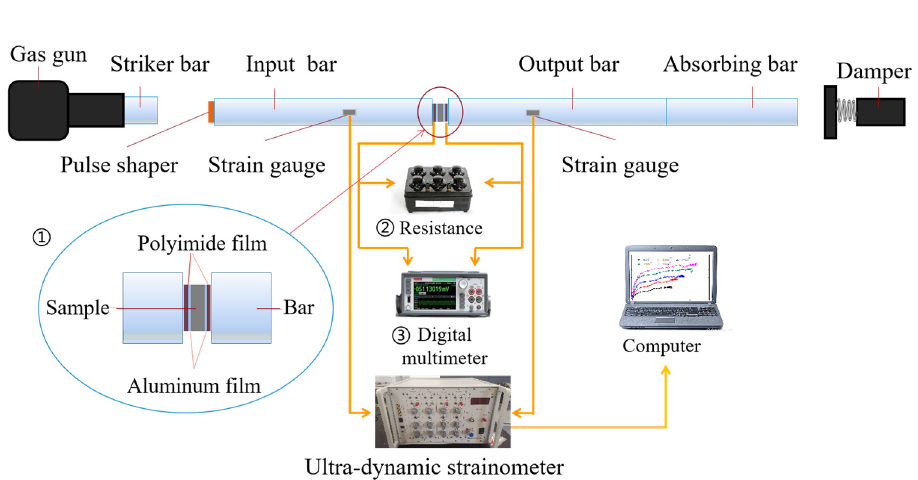
Figure 3. Schematic diagram of the SHPB device and the electric signal output system of the piezoelectric composite.